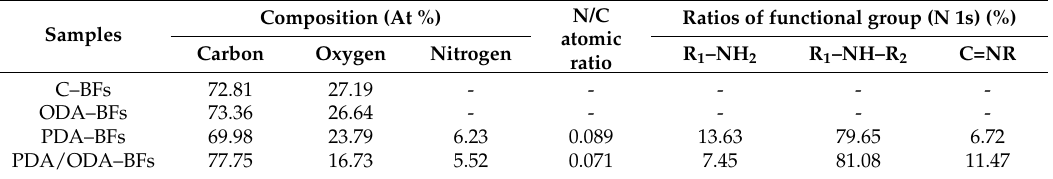
Table 3. Relative Concentration of Compositional Atoms and N 1s Functional Groups for BFs samples.